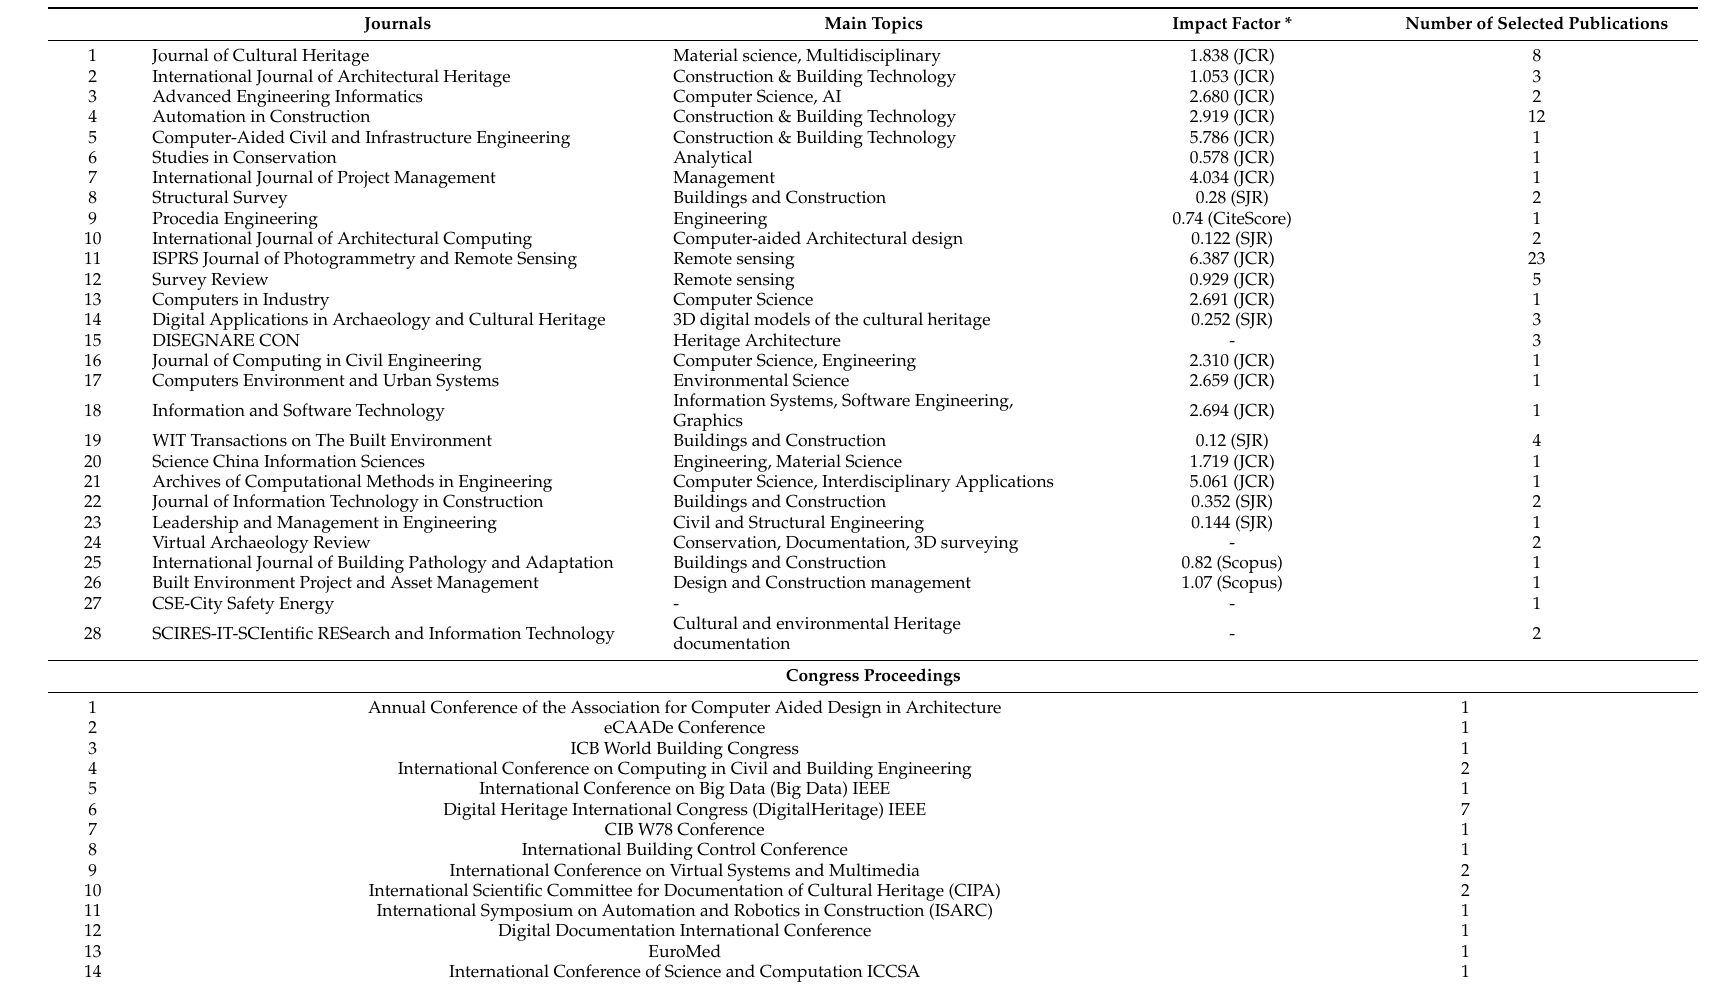
Table 1. Flow of